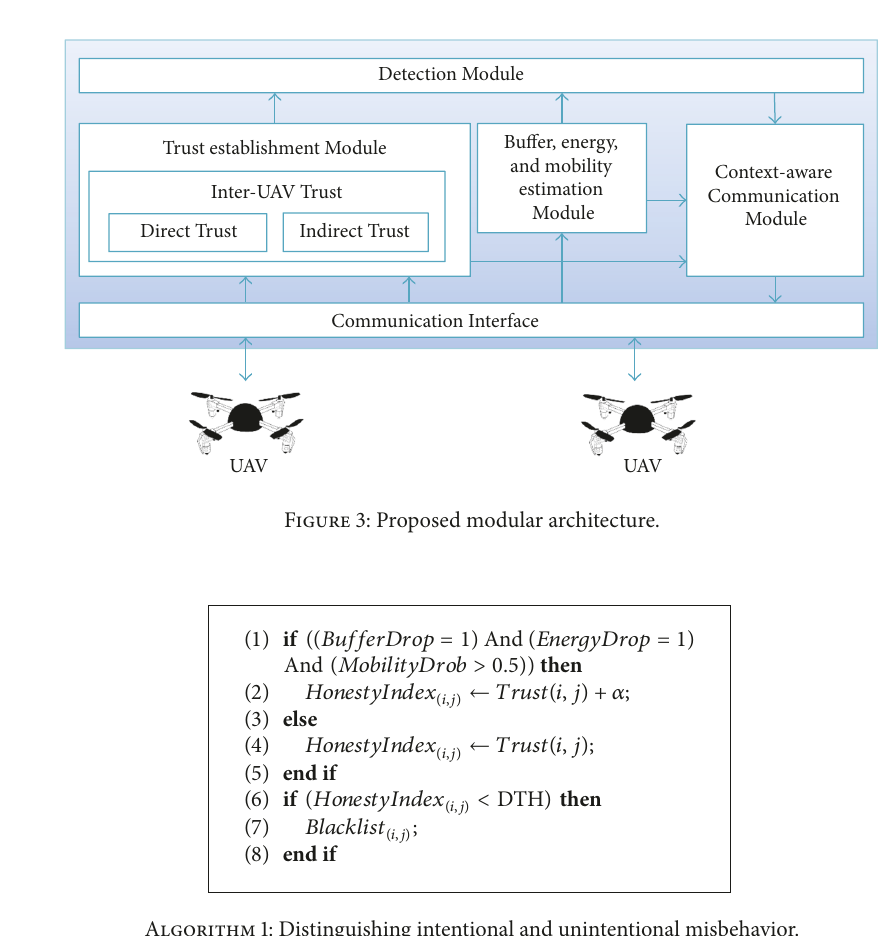
Algorithm 1: Distinguishing intentional and unintentional